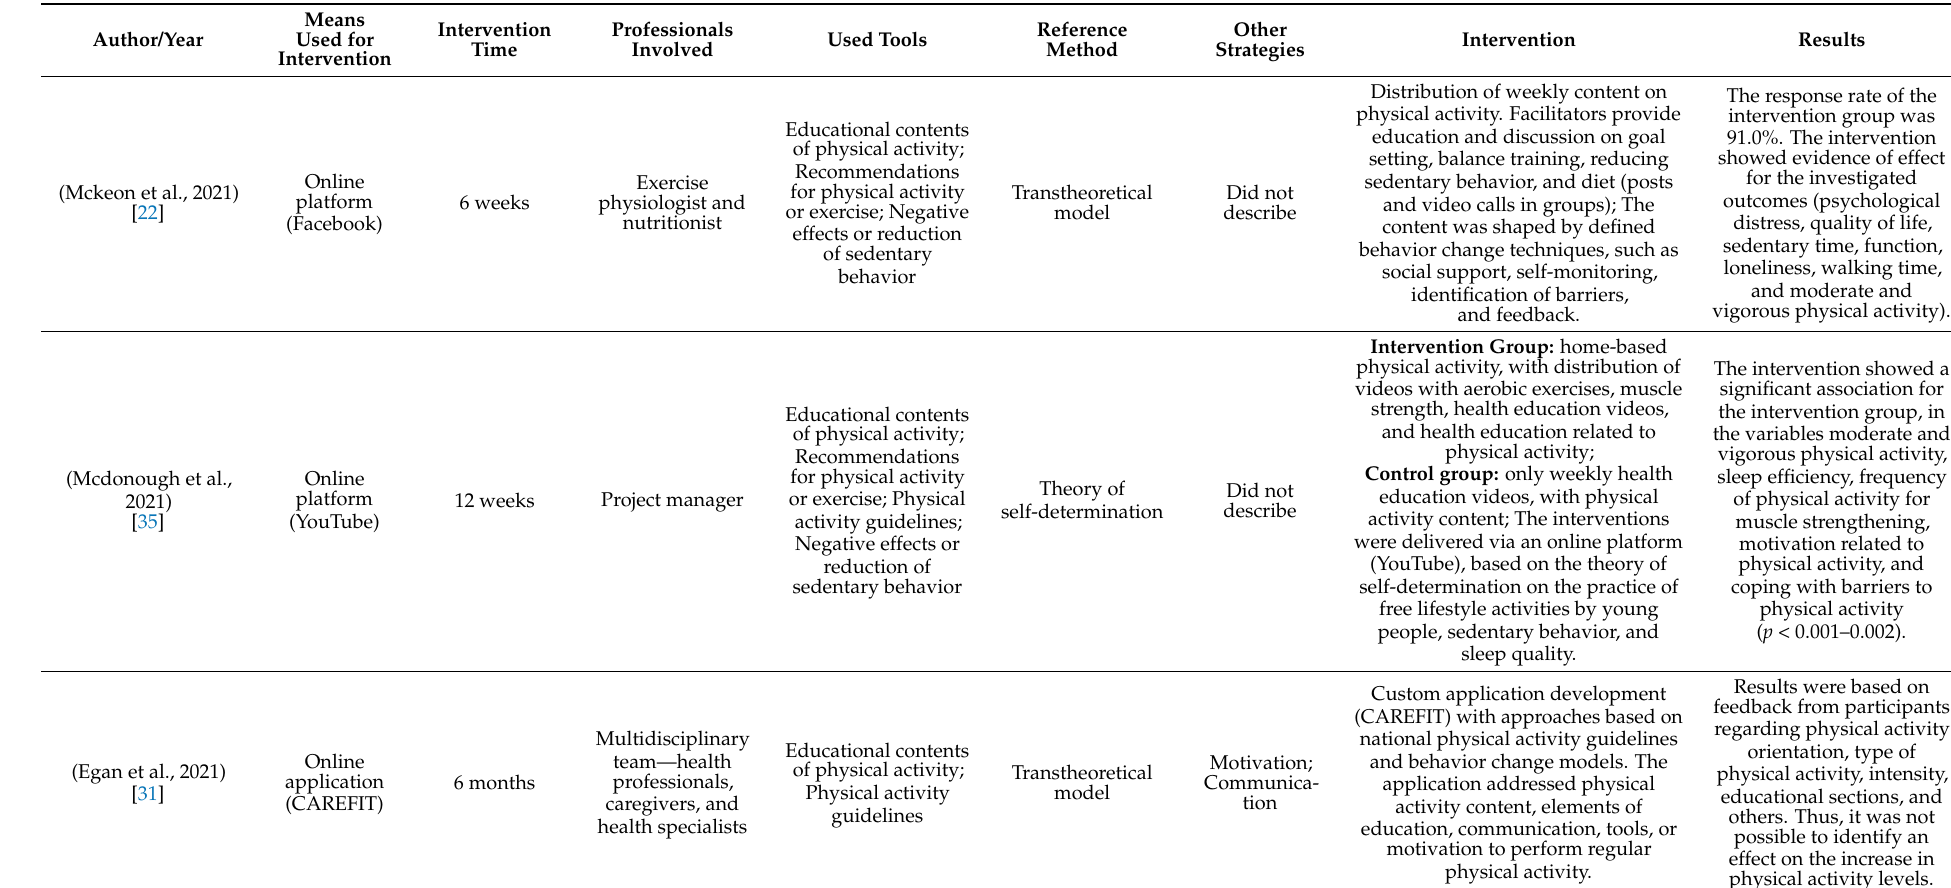
Table 2. Synthesis of key findings on physical activity counseling during